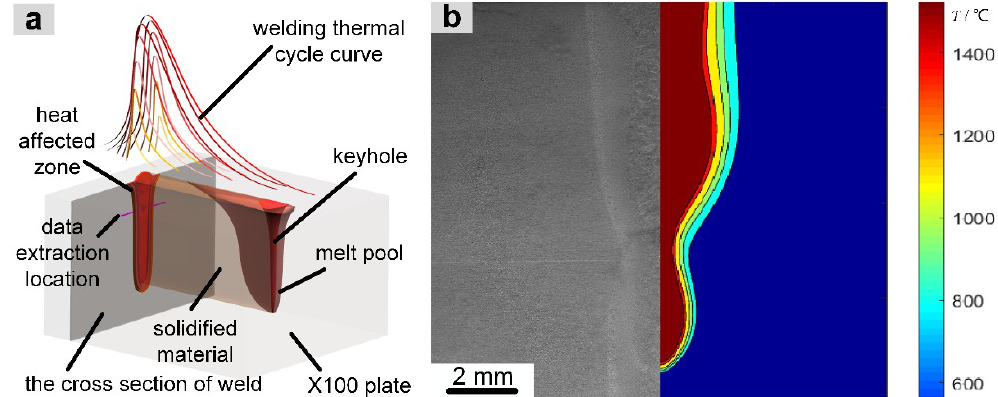
Figure 2. Principle of laser welding ( a ) and comparison of the temperature field simulation and experimental results ( b ) for X100 pipeline steel.